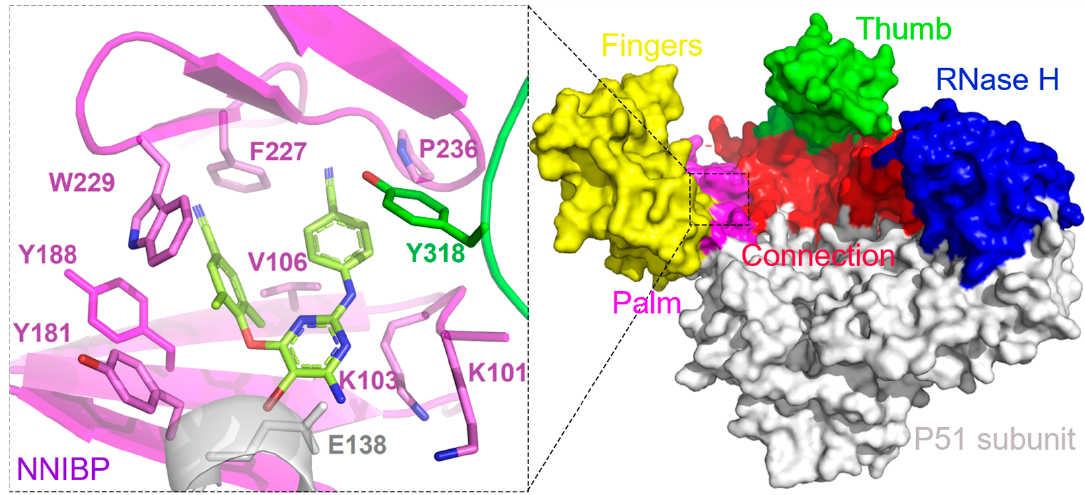
Figure 1. Cocrystal structure of etravirine/HIV-1 RT (PDB code: 3MEC) [11].